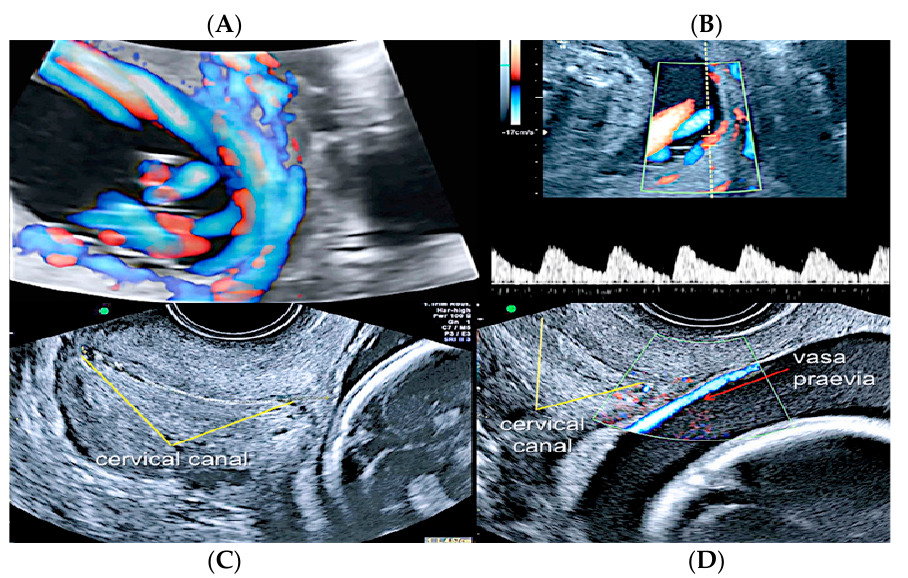
Figure 16. Second trimester transvaginal scan and three-dimensional ultrasound with “glass-body” rendering ( A ), Doppler ultrasound ( B ) and two-dimensional ultrasound showing the anatomical relationship between the cervical canal (yellow lines) (C) and the presence of vasa praevia (red arrow) ( D ).